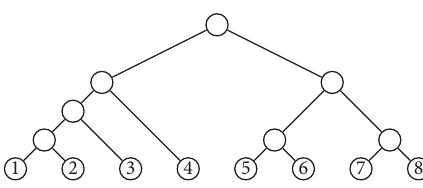
̃𝑇 ∈ T 8 used in Remark